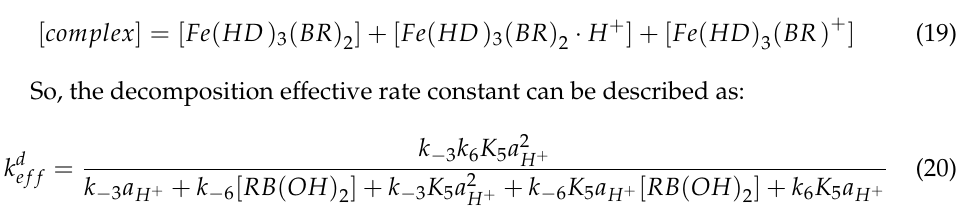
Scheme 4. Most plausible pathway of the acidic decomposition of the n- butyl- and phenylboron- capped iron(II) alicyclic tris- α -dioximates. Adapted from